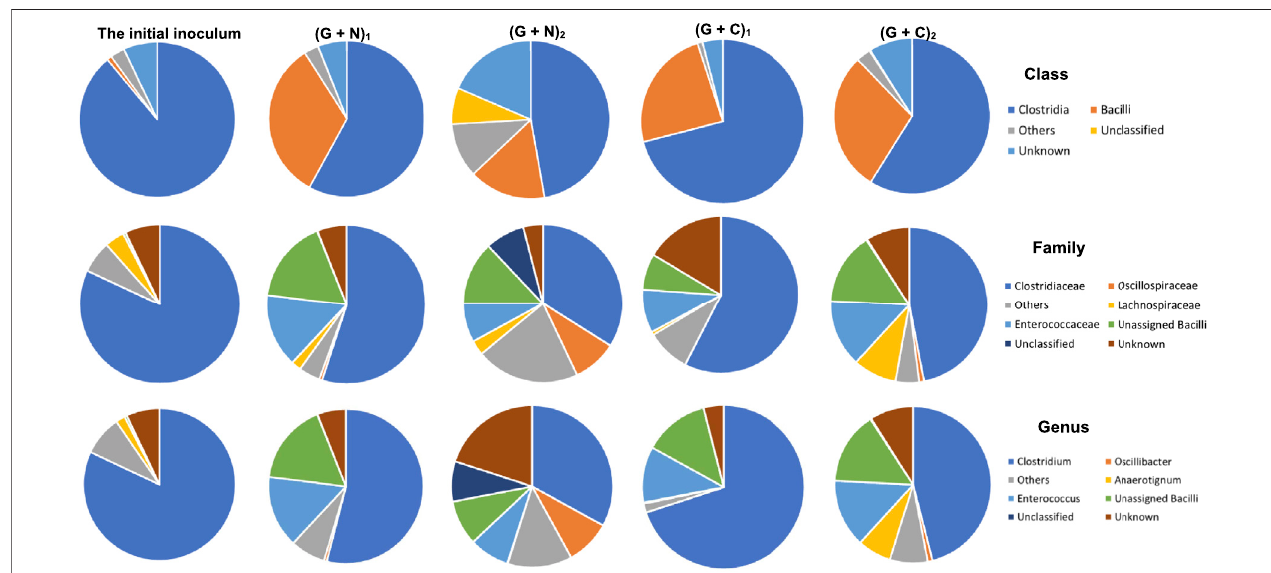
FIGURE 7 | The microbial community analysis of the initial inoculum, after glucose fermentation and CO and glucose co-fermentation from 6 th transfer. “ (G + N) 1 ” represents when glucose was totally consumed using glucose as substrate and “ (G + N) 2 ” represents at the end of the incubation after CO was added. “ (G + C) 1 ” represents when glucose was totally consumed and “ (G + C) 2 ” represents at the end of the glucose and CO co-fermentation incubation.